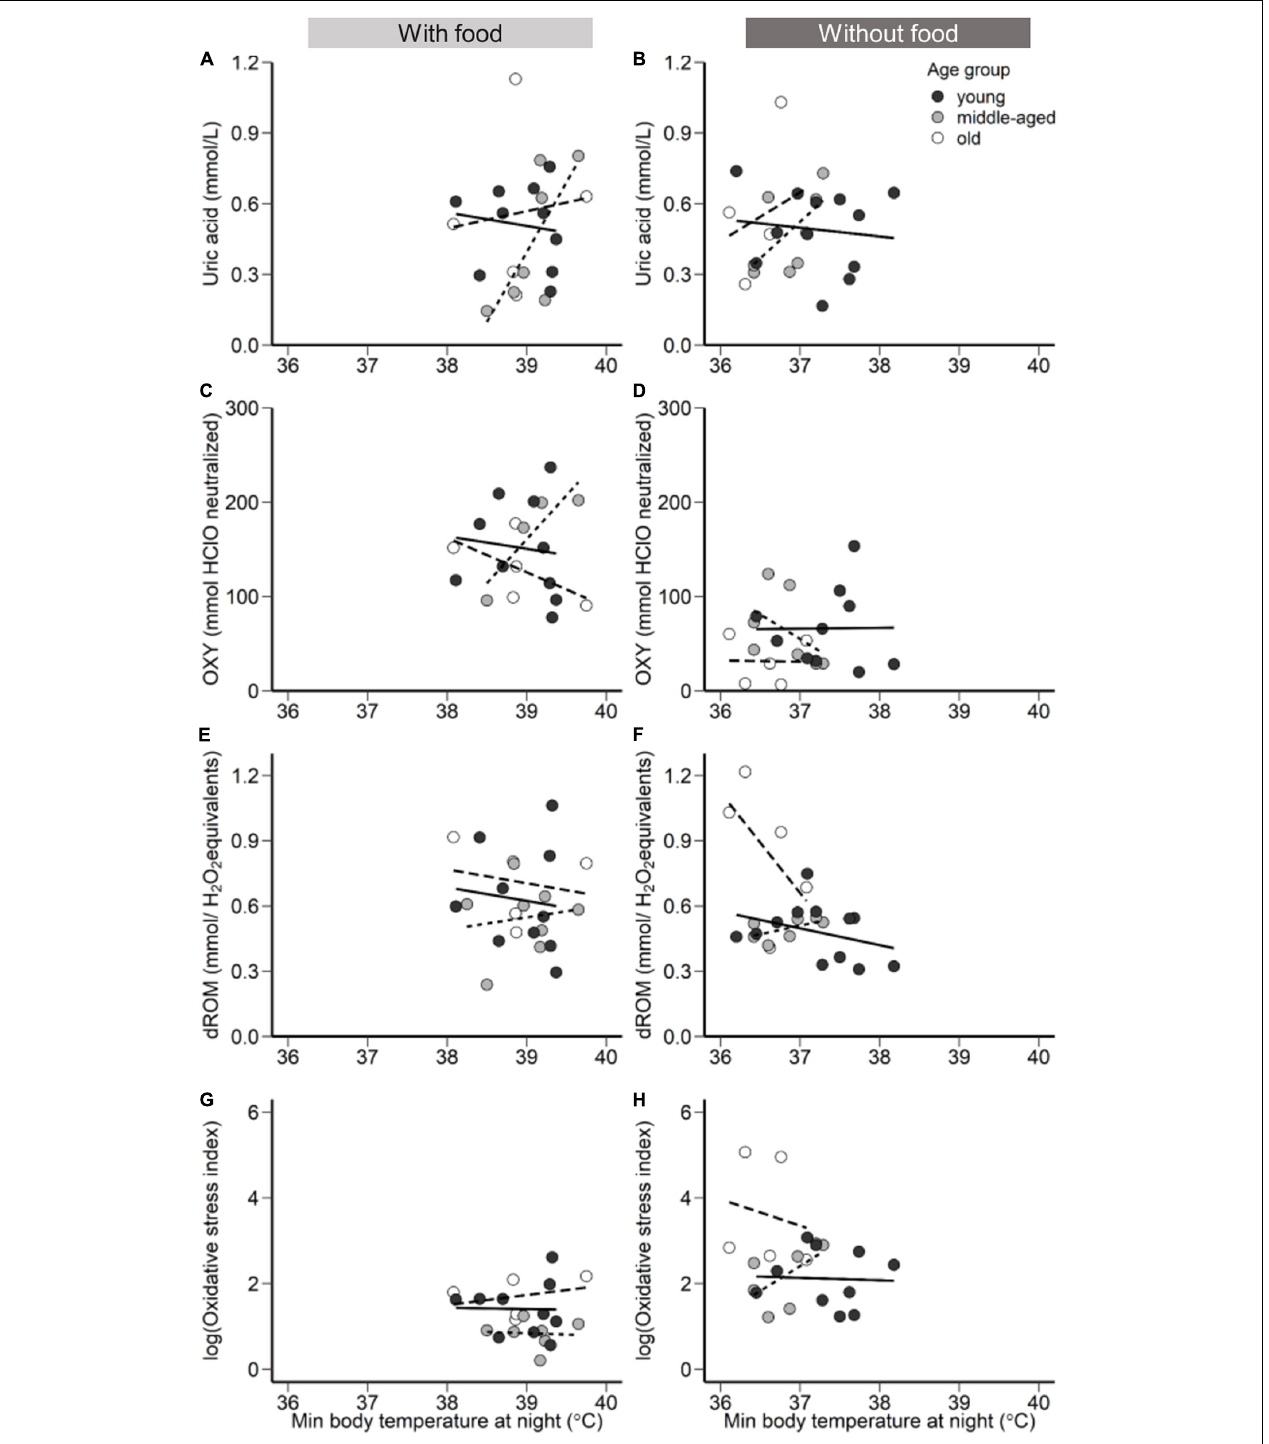
FIGURE 4 | The relationship between minimum body temperature during the night with access to food (left panels) and without access to food (right panels). (A,B) Uric acid (mmol/L), (C,D) , OXY (mmol HClO neutralized), a metric for non-enzymatic antioxidant capacity, (E,F) dROM (mmol/H 2 O 2 equivalents), a metric of oxidative damage, in plasma concentration, and (G,H) Oxidative stress index (log transformed), calculated as the ratio of the oxidative damage to the total non-enzymatic antioxidant capacity in the plasma multiplied by 1000. Points represent minimum body temperature values for each individual during the night following a day with access to food (left panels) and following a day without access to food (right panels). Black filled circles and solid regression line represent young group, gray filled circles and dotted regression line the middle-aged, and white filled circles and the dashed regression line old group of birds.